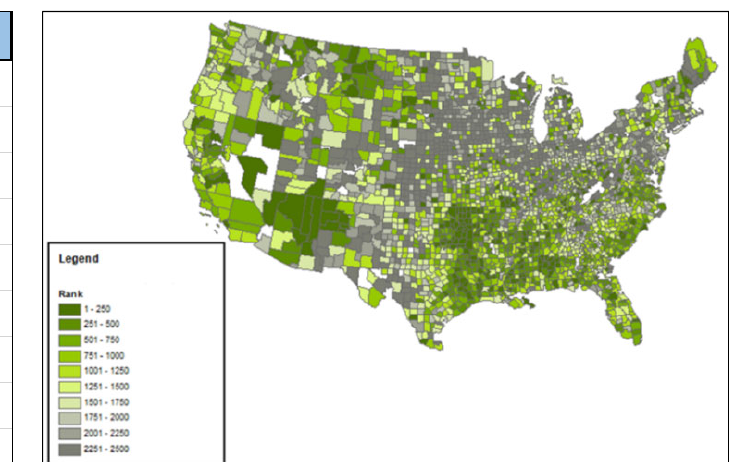
Table 10. Region Ranking: Non-White Principal Operator, 2012